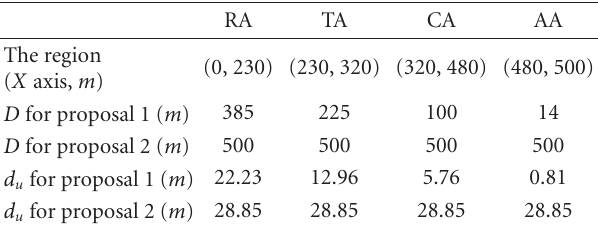
Table 3: The parameters for optimum